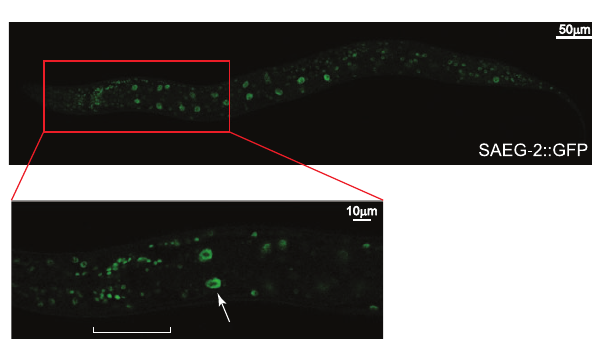
Figure 2. SAEG-1 and SAEG-2 act downstream of EGL-4 to control foraging behavior. (A) Foraging behavior of wild-type (WT), egl-4 , saeg-1 and saeg-2 mutant animals. Quantitation of behavior was performed as in Figure 1A. Data for WT and egl-4(gf) animals are the same as in Figure 1A. Total number of trials for all other strains: n=5. (Mean 6 SD; pair-wise t-test, *, p , 0.05 ). (B) Schematic representations of SAEG-1 and SAEG-2 protein. Conserved domains are indicated; ZnF, C2H2 zinc finger. Mutant alleles together with corresponding changes in protein coding sequences are indicated. The saeg-2(hj9) molecular lesion is not shown because it affects the splice donor site of intron 3. (C) Nuclear localization of SAEG-1::GFP